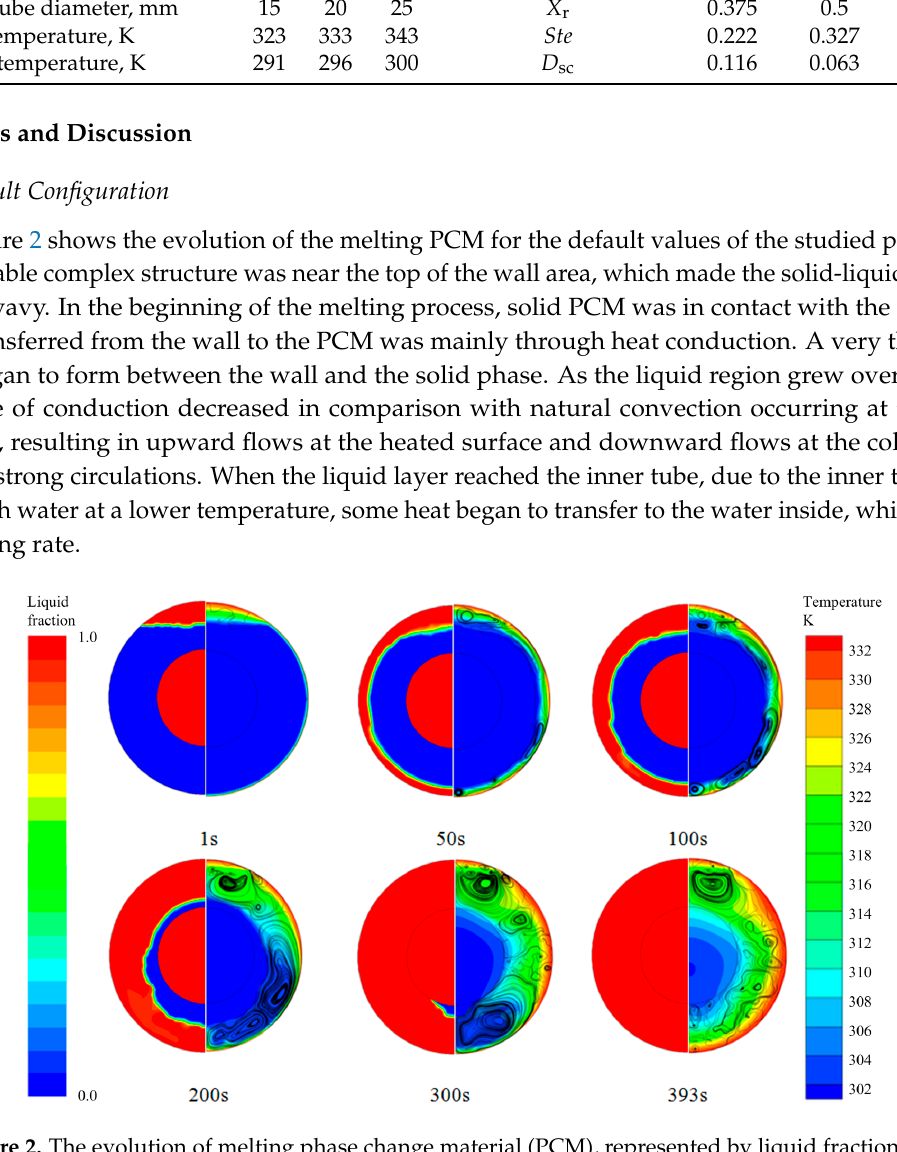
Figure 2. The evolution of melting phase change material (PCM), represented by liquid fraction ( left ) and temperature contour ( right ), for the default configuration.